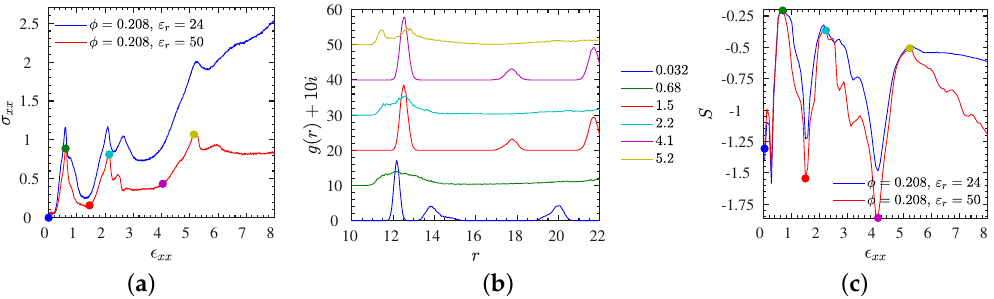
Figure 11. Structural transition data for the entangled L2 • and L2 ◦ systems at an identical and relatively small strain rate ˙ (cid:101) xx = 0.001. ( a ) Stress–strain curves for L2 • (blue) and L2 ◦ (red lines), ( b ) NP–NP pair correlation function calculated at different stretching strains for the L2 ◦ system. The curves are shifted upward by their index i = 0,...,5 where, e.g., i = 0 for the blue (bottom) line and i = 5 for the yellow (top) line. The line colors in ( c ) correspond to the observations (colorful symbols) made in ( a , c ) at the same strain (cid:101) xx values. ( c ) Disorder parameter S versus strain for both L2 •